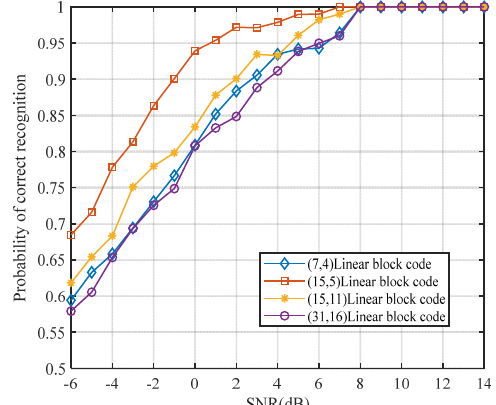
Figure 15. Influence of linear block code parameters on the recognition rate under the Condition of Gaussian White